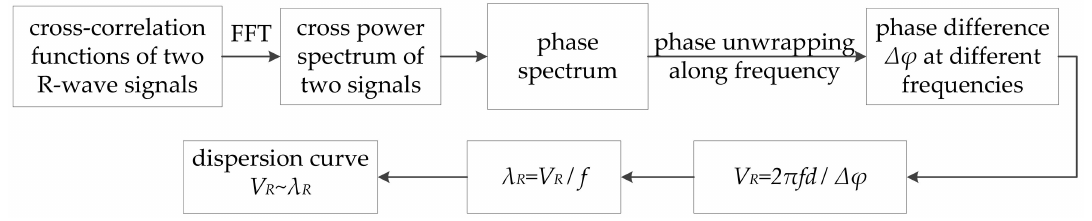
Figure 3. Matlab implementation procedures of the SASW